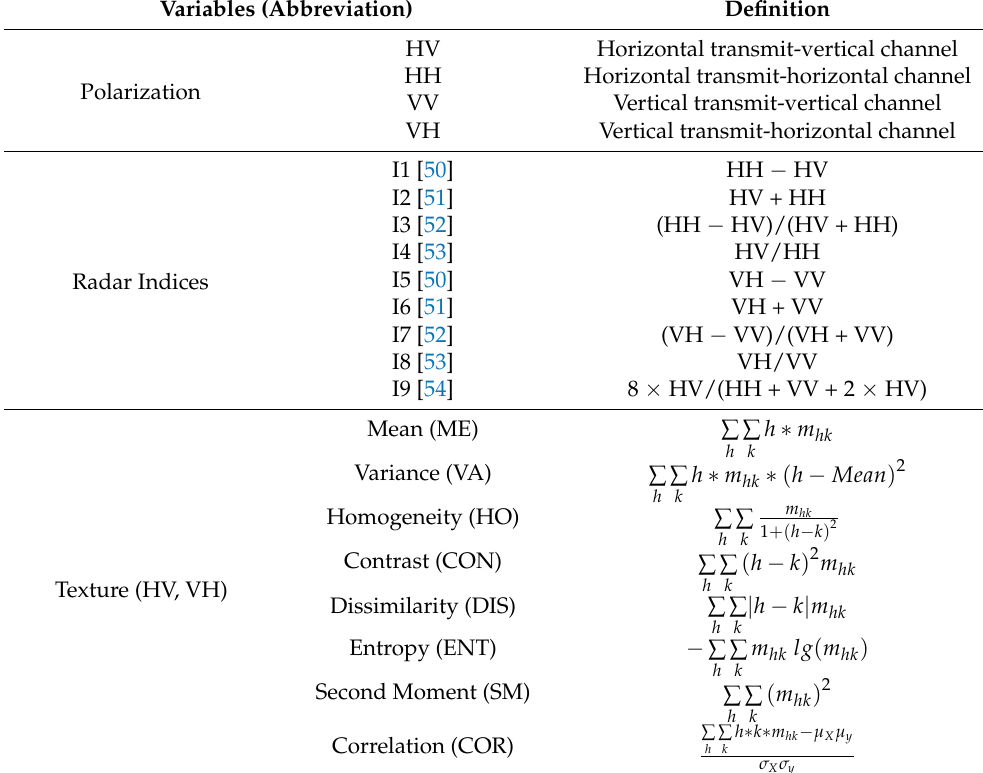
Table 3. List of variables from the PALSAR-2 data. In the texture calculations, h represents high of row number, k represents column number of image window and m hk refers the value in the cell h , k of the image